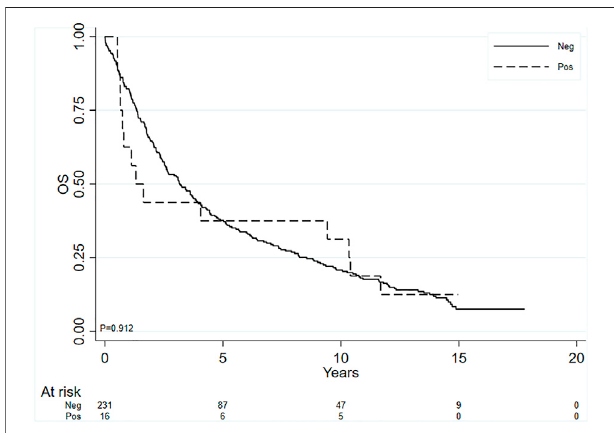
FIGURE 3 | Kaplan-Meier curves for OS, comparing the subgroup of patients with both PD-L1 and vimentin positive in tumor cells (cutoff value ≥ 50% for both the biomarkers) with all the others.